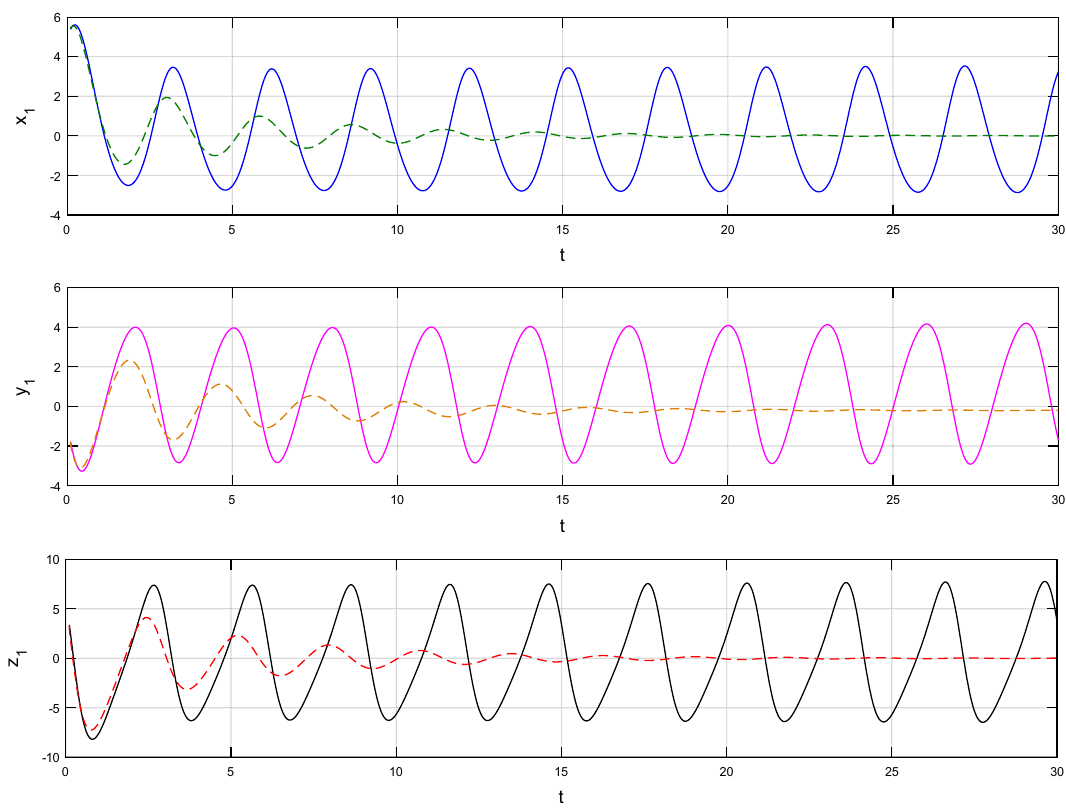
Figure 5. An analysis of the chaotic attractors for this case when α = 1 (line) and α = 0.90